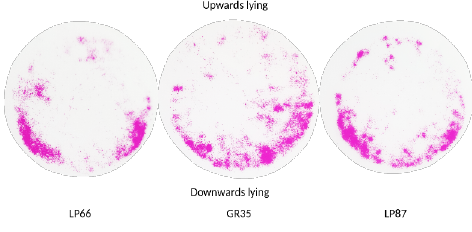
Figure 5. Discoloration of the fi lm after pressure loading on a tilted (approximately 30 ◦ )